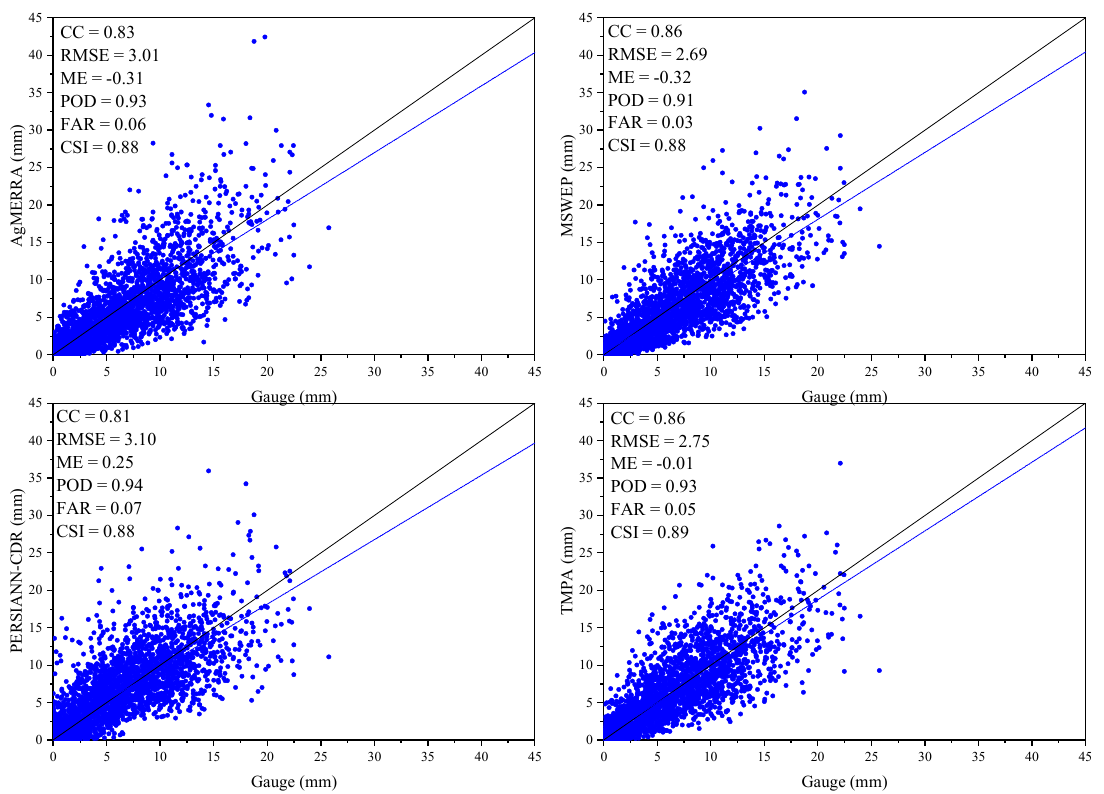
Figure 2. Scatterplots of precipitation comparison for Mekong River basin at daily scale between satellite/reanalysis precipitation products and gauge. The black line is diagonal line, and the best-fit line, which used the least squares method, is